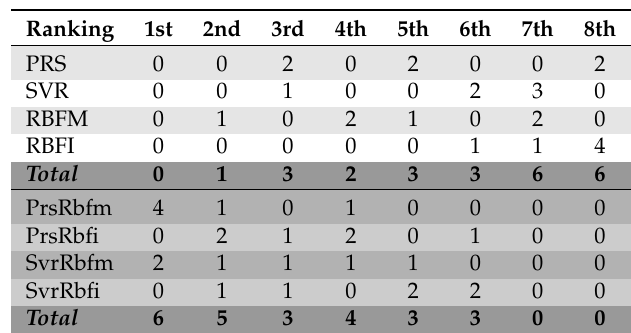
Table 3. Frequency of the accuracy ranking (using RMSE) of the metamodels for the six benchmark ( k + 1 )( k + 2 ) problems with 3 training points. 2